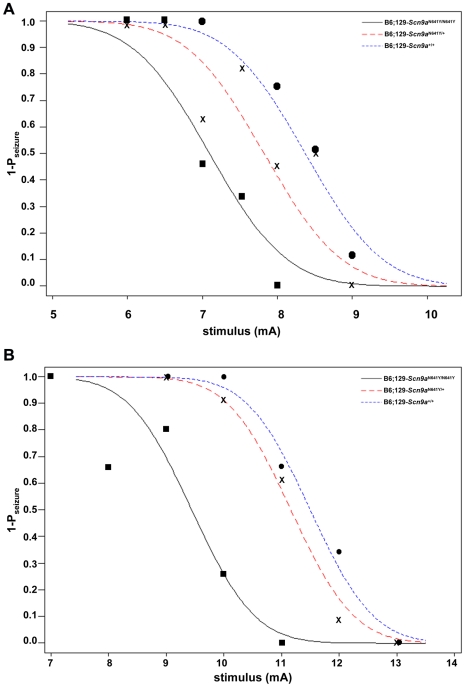
Reduced electroconvulsive seizure thresholds of Scn9a knockin mice compared to wild-type littermate controls.Convulsive current curves generated by testing (A) male B6;129-Scn9a
N641Y/N641Y, B6;129-Scn9a
N641Y/+, and B6;129-Scn9a
+/+ mice to minimal clonus electroconvulsive seizures (B6;129-Scn9a
N641Y/N641Y vs B6;129-Scn9a
N641Y/+
p = 0.008; B6;129-Scn9a
N641Y/N641Y vs B6;129-Scn9a
+/+
p = 0.001; B6;129-Scn9a
N641Y/+ vs B6;129-Scn9a
+/+
p = 0.093) and (B) female B6;129-Scn9a
N641Y/N641Y, B6;129-Scn9a
N641Y/+, and B6;129-Scn9a
+/+ mice to minimal tonic hindlimb extension electroconvulsive seizures (B6;129-Scn9a
N641Y/N641Y vs B6;129-Scn9a
N641Y/+
p<0.001; B6;129-Scn9a
N641Y/N641Y vs B6;129-Scn9a
+/+
p<0.001; B6;129-Scn9a
N641Y/+ vs B6;129-Scn9a
+/+
p = 0.227). Convulsive current data are expressed in terms of 1-seizure probability (1-Pseizure) for a given stimulus (mA). Individual data points shown for homozygote (closed square), heterozygote (x), and wild-type (closed circle) mice are used to construct curves indicated by black solid, red dashed, and blue dotted lines, respectively.